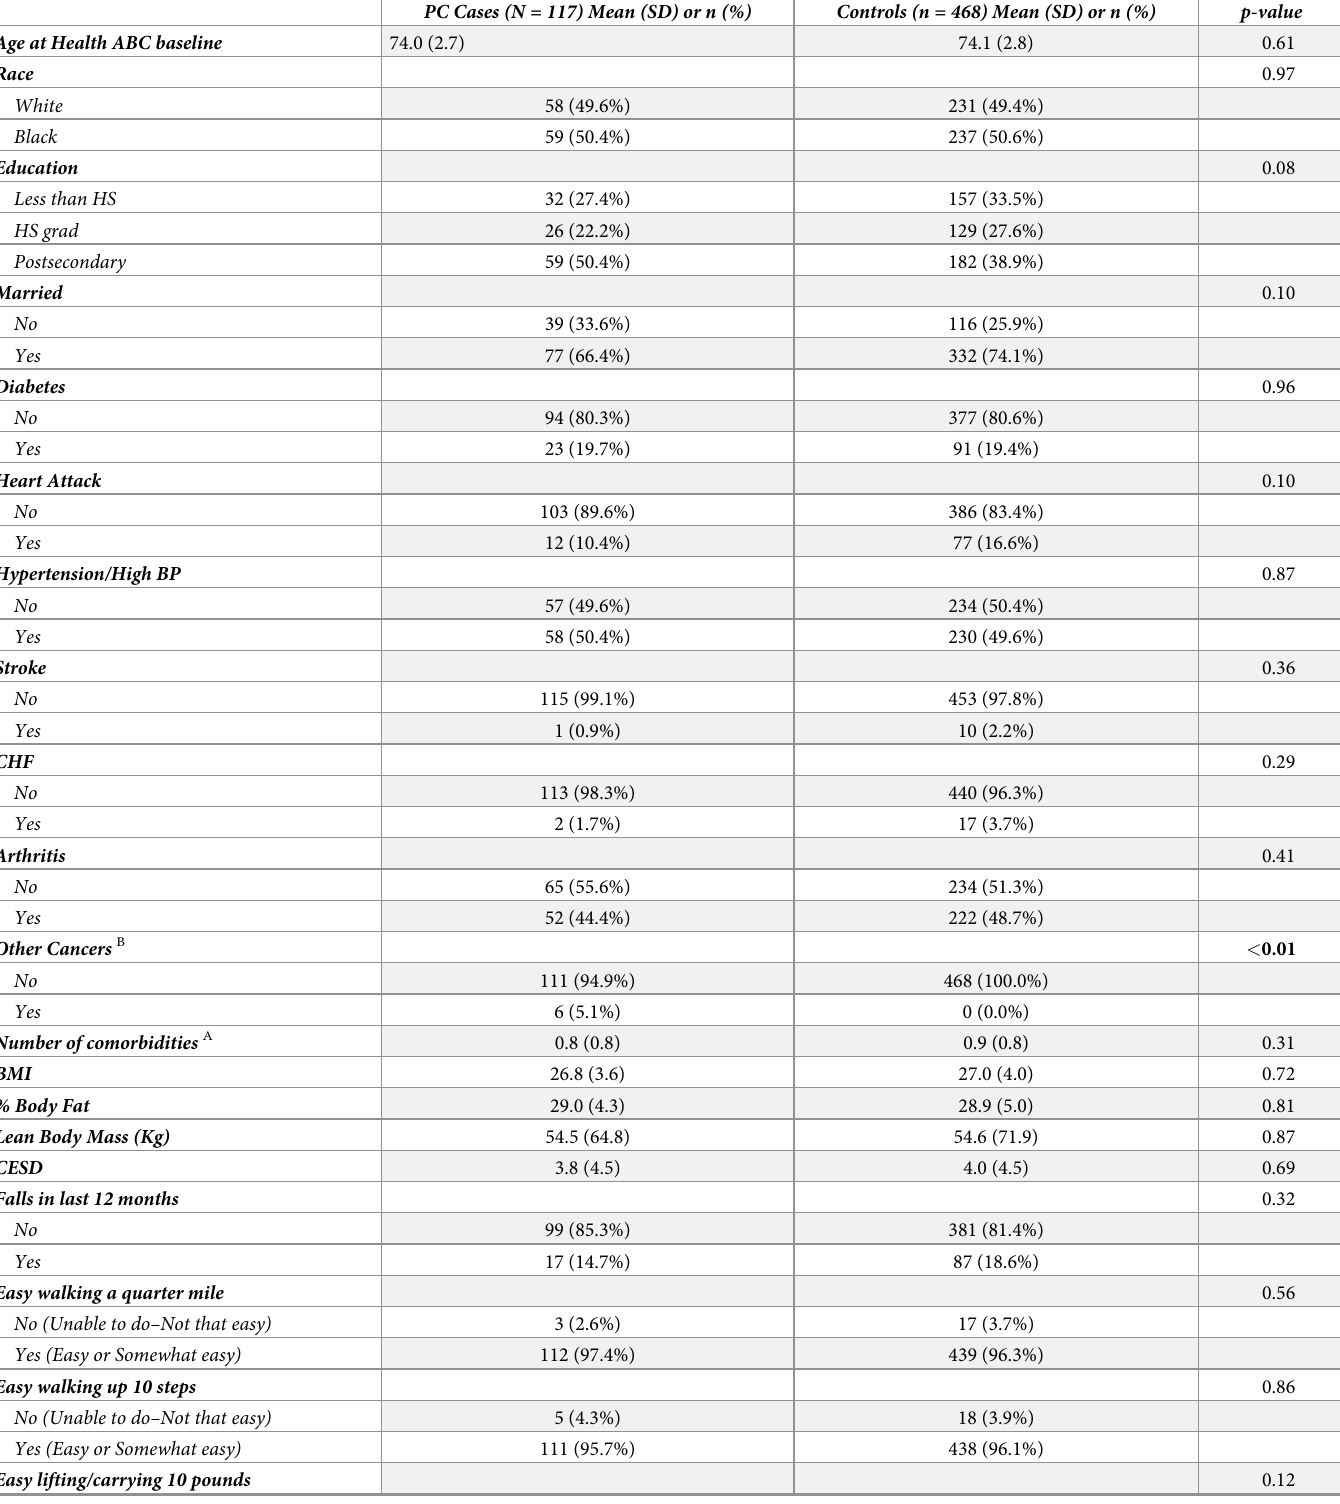
Table 1. Characteristics of the study sample at Health ABC study